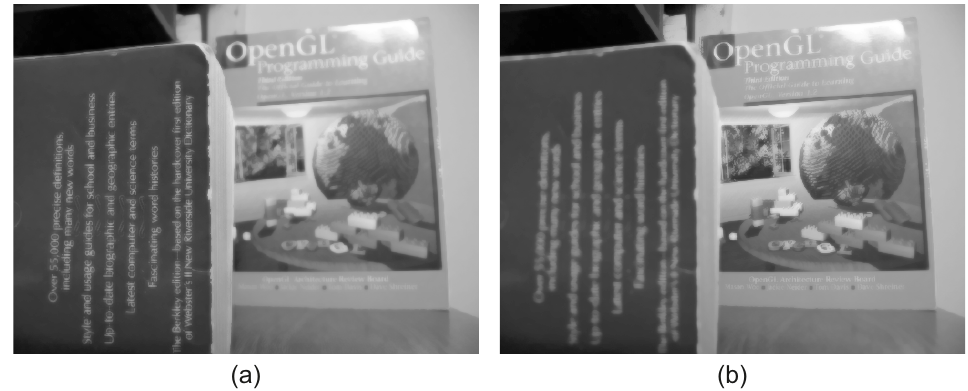
Figure 3. Low frequency of input images using the EAC: ( a ) Low frequency of near focused image, ( b ) Low frequency of far focused image. It is evident that the EAC preserves the strong image edges. By subtracting the low-frequency images from the input images, we extract the high- frequency images as demonstrated in Figure 4. The forward ICA transform is then applied to the high-frequency images in order to get the transform domain coefficients. For more information on the estimation of the ICA transform, and its application on images for fusion, please refer to [11].